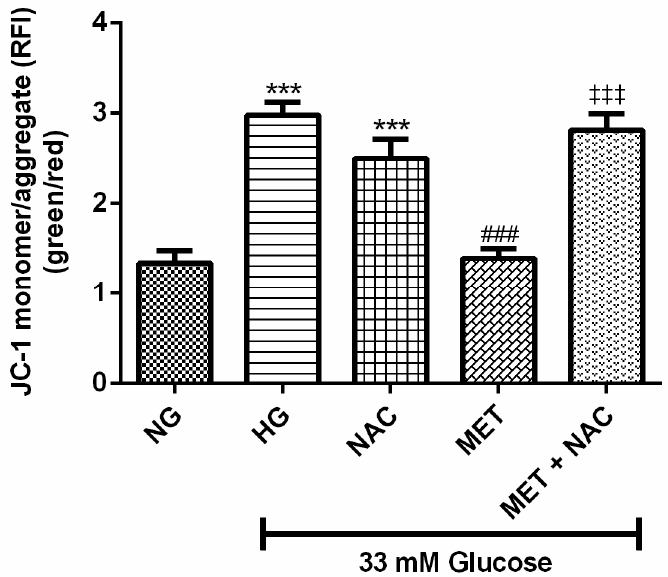
Figure 7. The combination effect of Metformin (MET) and N-acetylcysteine (NAC) on mitochondrial potential. H9c2 cardiomyoblasts were cultured in high glucose (HG; 33 mM) for 24 h. Thereafter, cells were treated with NAC (1 mM), metformin (MET) (1 µM) and a combination of MET+NAC. Cells treated with normal glucose (NG) served as the vehicle control. Data are presented as the mean ± SEM of 3 separate biological experiments with each experiment having 3 technical repeats ( n = 9). Significance is depicted as *** p ≤ 0.001 versus NG control, ### p ≤ 0.001 versus HG control and ‡‡‡ p ≤ 001 compared to MET.